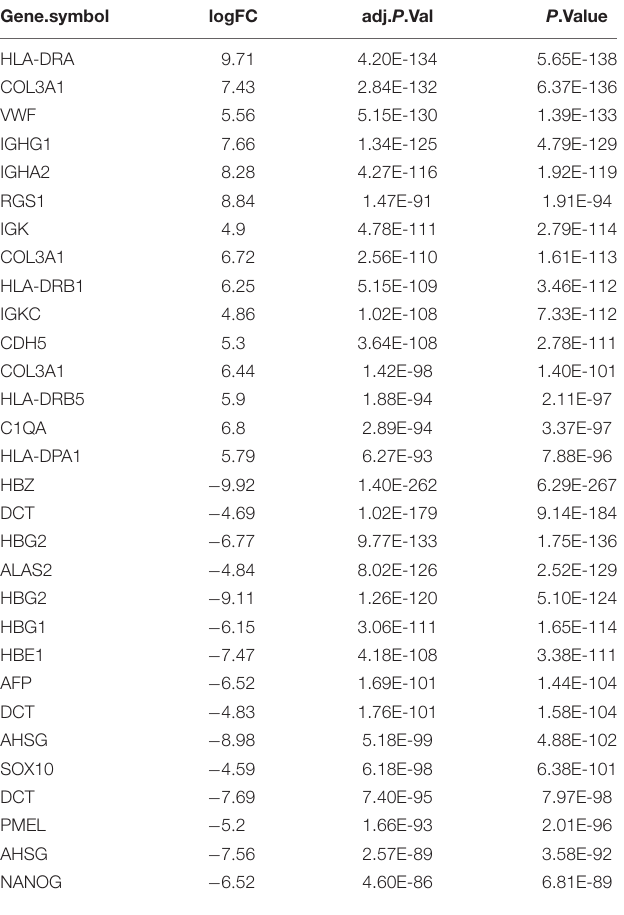
(Normal-vs.- Adenocarcinoma, P = 2.195E-02) ( Figure 4D ), gender (Male-vs.-Female, P = 1.338E-03) ( Figure 4E ), smoking habits (Normal-vs.-Smoker, P = 1.319E-11) ( Figure 4F ), stage (Normal-vs.-stage1, P = 3.458E-02) ( Figure 4G ), TP-53 mutation state (Normal-vs.-TP53 mutation, P = 1.624E-12) ( Figure 4H ), Weight (Normal-vs.-weight, P = 2.978E-2) ( Figure 4I ). The expression of CDK2 was related to the survival and prognosis of patients with LUAD (HR = 1.66, P = 5.8e-15) ( Figure 4J ). The higher the expression of CDK2, the shorter the survival time. Through this database, we shown in Figures 4K,L . Many molecules involved in tumor